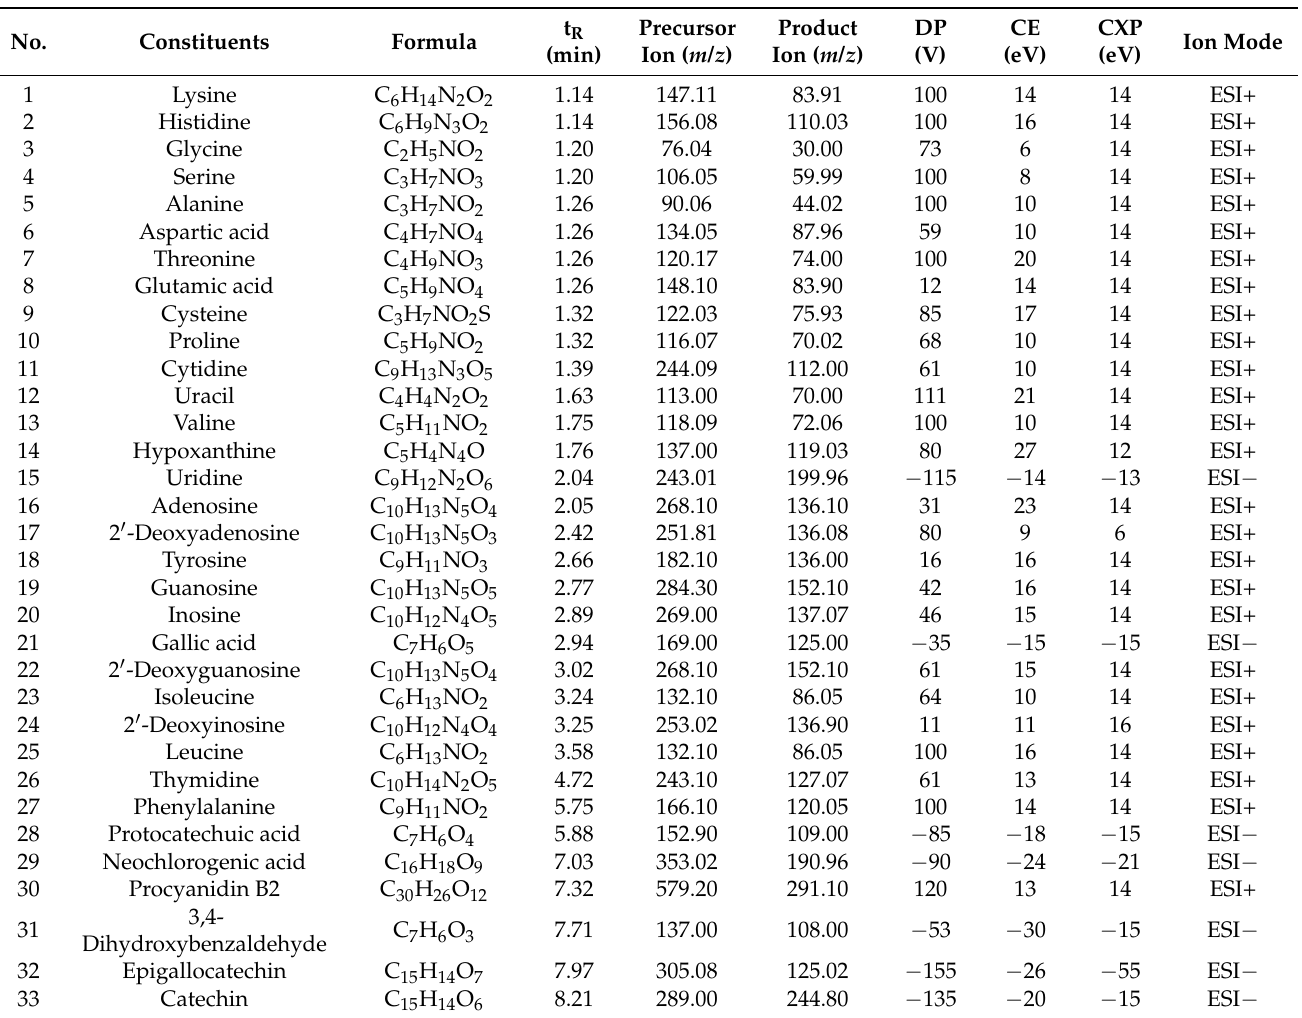
Table 1. Optimized mass spectrometric parameters for MRM of 60